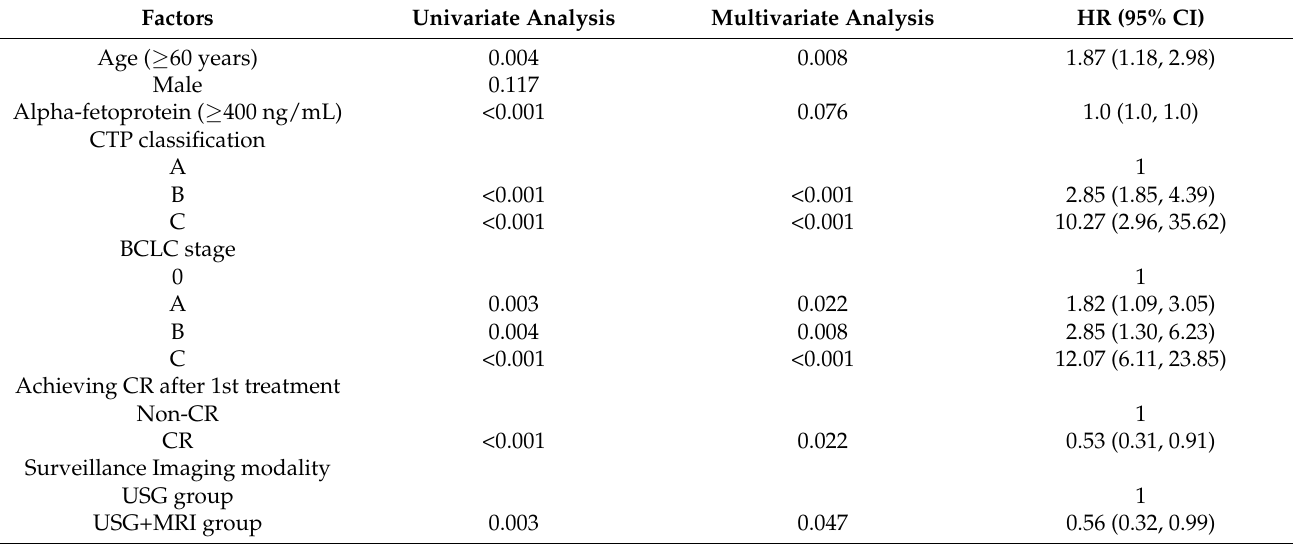
Table 2. Factors affecting the overall survival.